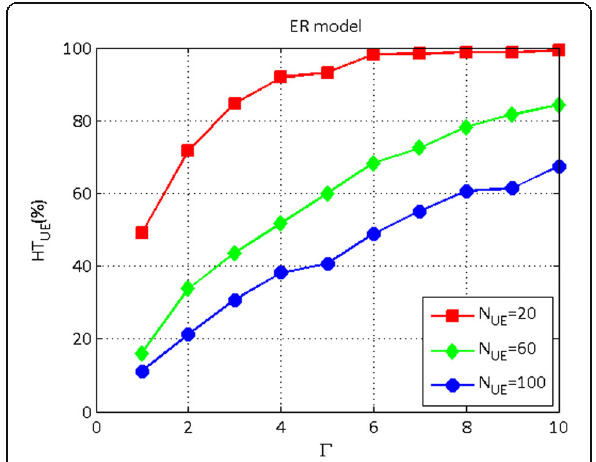
Fig. 13 Impact of nodes number to hit rate in the UE level in ER model ( d UE ¼ 4)